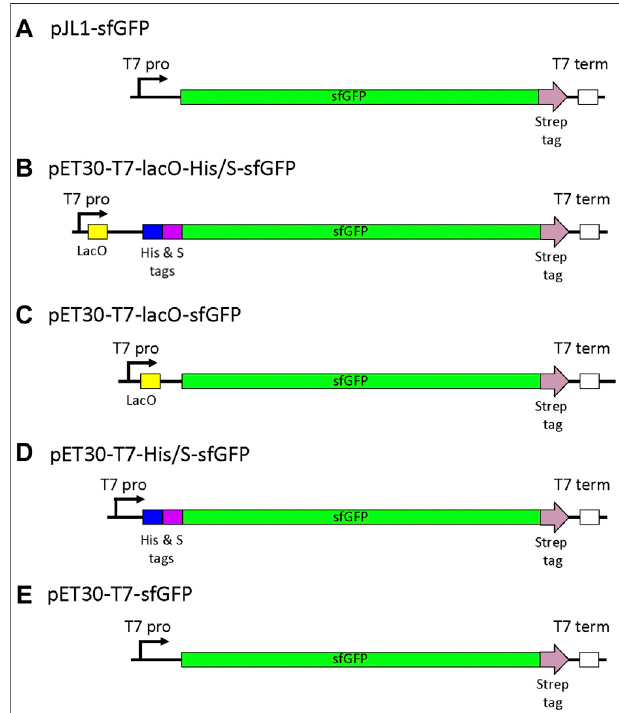
FIGURE 1 | Schematic of the expression vectors studied. (A) pJL1- sfGFP represents the reference vector, (B) the pET30-T7-lacO-His/S-sfGFP cassette contains the T7 promoter (T7 pro) followed by lacO and a N-terminal puri fi cationtags(HisandStags)includedinthepET30vectorbackbone. Modi fi cations of the pET30 expression cassette included the deletion of (C) theN-terminalHis/S-tags, (D) lacO, and (E) both lacO andtheN-terminaltags to assess the effects on sfGFP expression. Similar to pET30-T7-sfGFP, the pJL1-T7-sfGFP cassette includes the same T7 promoter but not the lacO nor the N-terminal His-tag. All templates used in this study were in their circular plasmid forms. While the backbone sequences are not displayed here, pET30a includes the lacI gene that is not present in the pJL1 backbone.